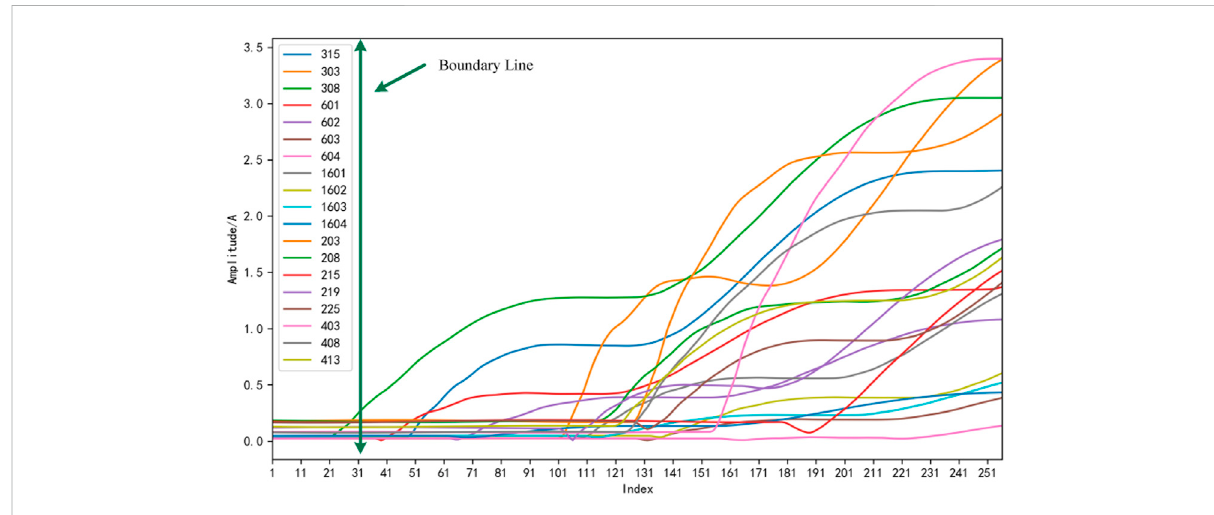
FIGURE 6 3I0 amplitude change curve when a single-phase grounding fault occurs in arc suppression coil grounded and ungrounded systems.